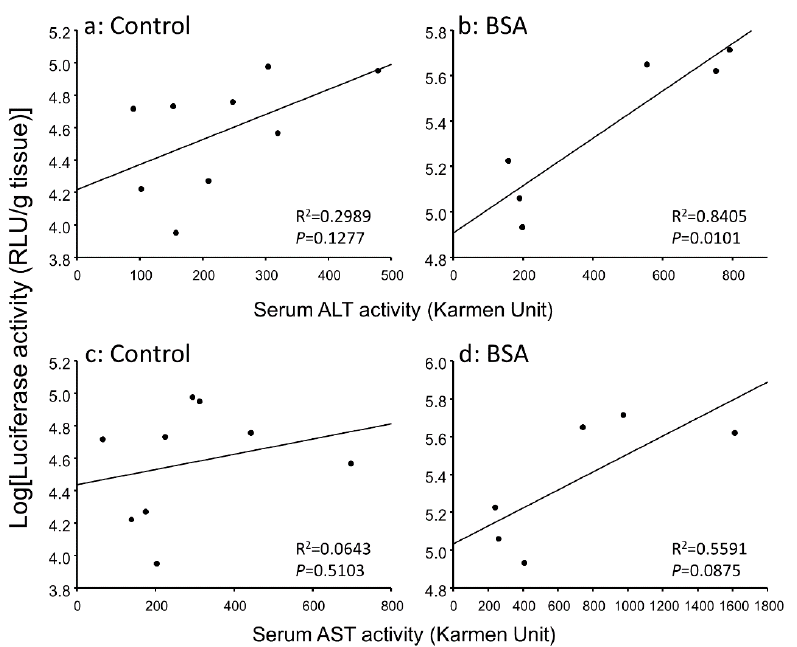
Figure 4. Relationship between hepatic gene expression level and serum ALT ( a , b ) or AST ( c , d ) activity level 6 h after i.v. injection of lipoplex incubated with 5% glucose ( a , c ) or BSA ( b , d ) in hepatitis mice. Solid line represents the regression curve.